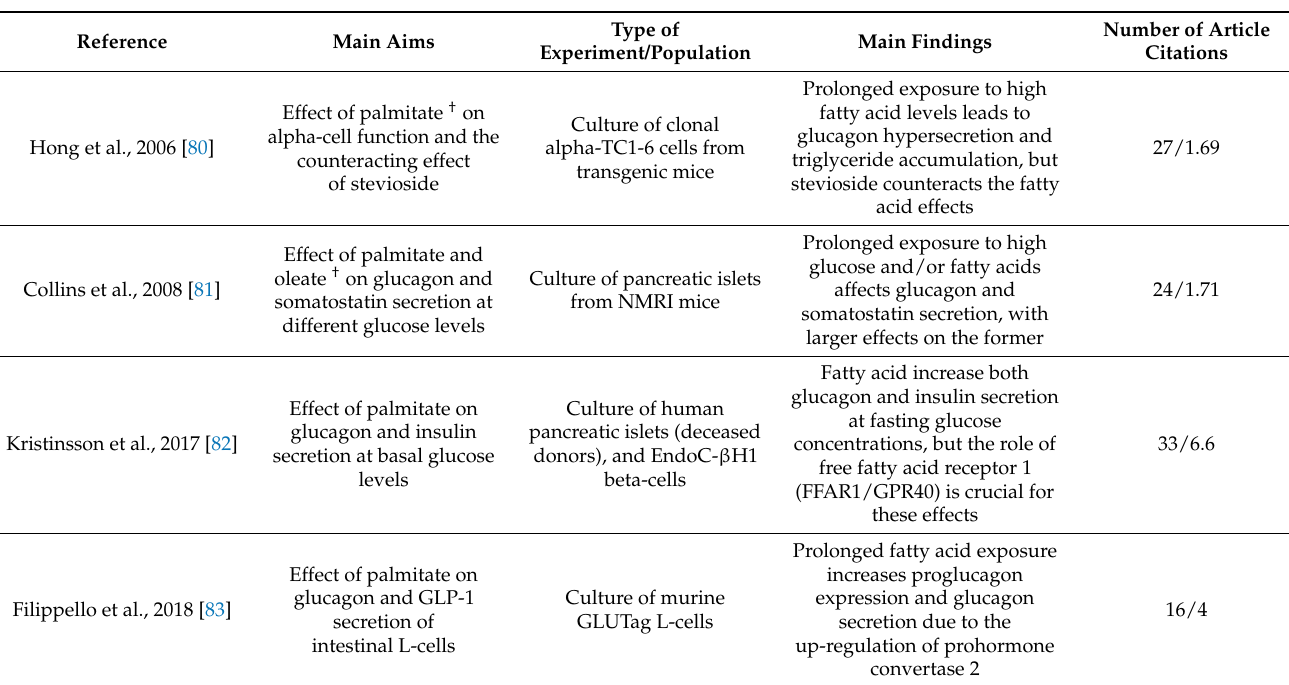
Table 2. Summary information related to the studies concerning the effects on the alpha cell of